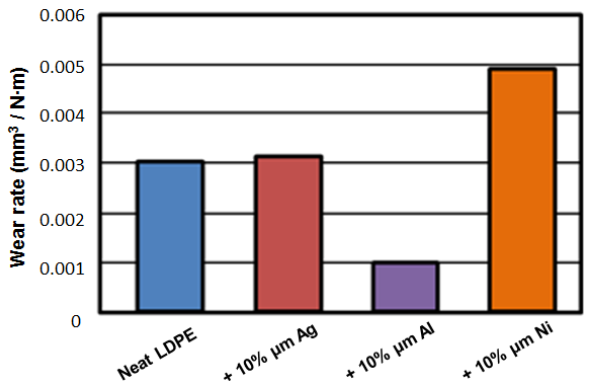
Figure 4. Wear rates for neat LDPE and LDPE-based microcomposites against carbon nitride pin balls. Labels indicate the percentage of metal micropowder in